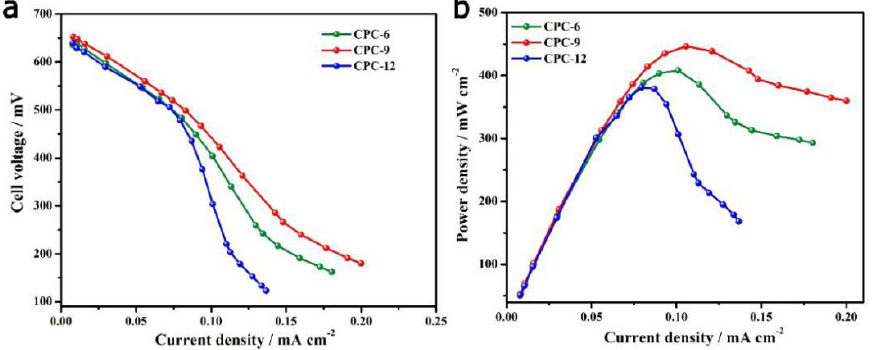
Figure 6. Polarization curves ( a ) and power curves ( b ) of MFCs equipped with di ff erent porous carbon